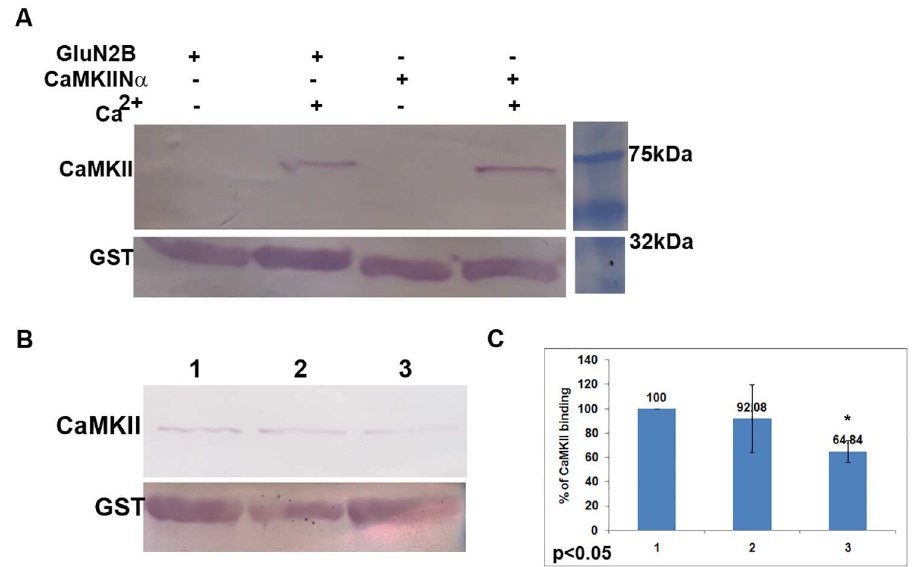
Fig 1. Calciumdependentbindingof CaMKIIN α to CaMKII. A: GST-pulldown assay was carriedout to show bindingof α -CaMKIIto GST-CaMKIIN α .Blot was cut into two pieces. Upperpartof the blot was probed with anti- α -CaMKII antibodyand the lower partwas probedwith anti-GSTantibody. Markeris fromthe same blot. S1 Fig shows SDS-PAGE patternof CaMKIIN α . B: GluN2B reducedCaMKIIbindingto CaMKIIN α . GST- pulldown assay was performedas describedin methods.Lane 1: GST-pulldown of CaMKIIwith GST-CaMKIIN α .Lane 2: CaMKIIN α was allowed to bind to CaMKIIfirst,followed by incubation with His- GluN2B. Lane 3: GST-CaMKIIN α and His-GluN2B were allowed to bind to CaMKIIsimultaneously. C: The mean ± standarddeviation of densitometricvalues of the band intensitiesobtainedfromthreeindependent experiments as shown in B are plotted.The bindingof CaMKIIwith GST-CaMKIIN α taken as the controlis considered as 100% binding.The bindingof CaMKIIin 2 and 3 are presentedas the relative bindingwith respectto controlin the bar graphs. The p value for the difference between 1 and 3 is less than 0.05 in two- tailedstudent’s